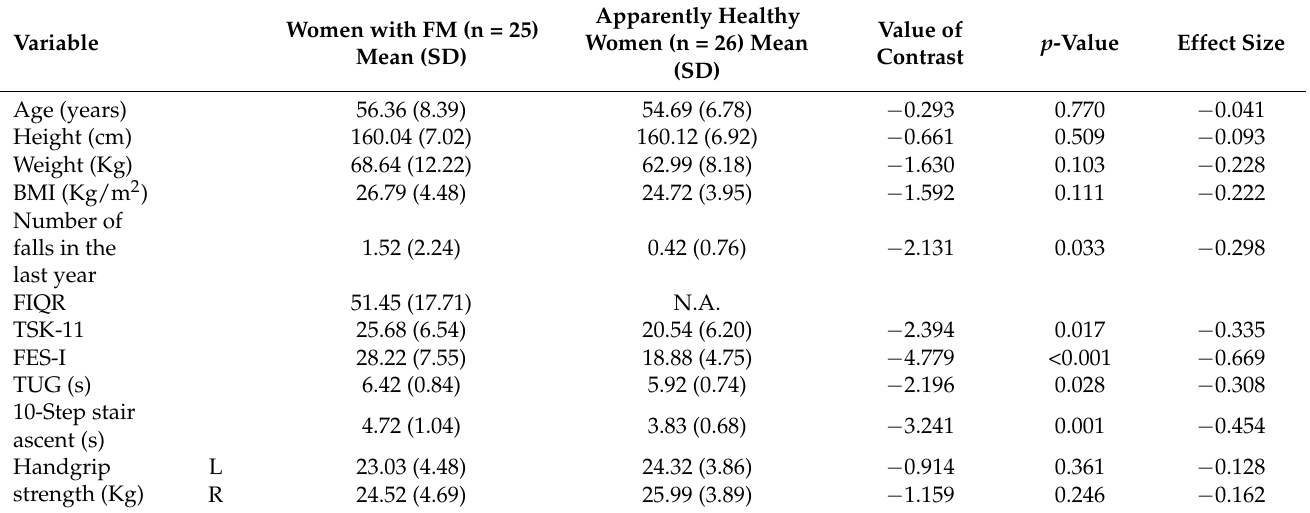
Table 1. Differences between groups in demographic, total score questionnaires, and physical fitness tests.